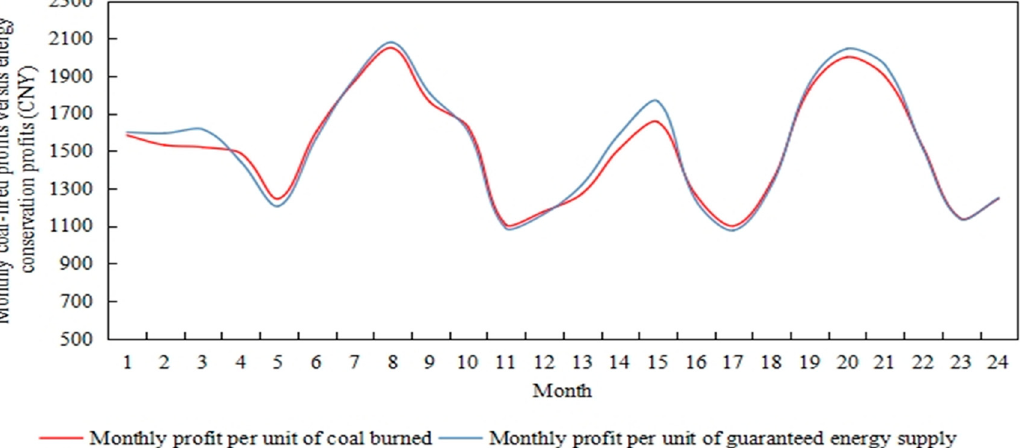
Figure 16. The comparison of monthly unit coal-fired profit and energy supply profit of power re-